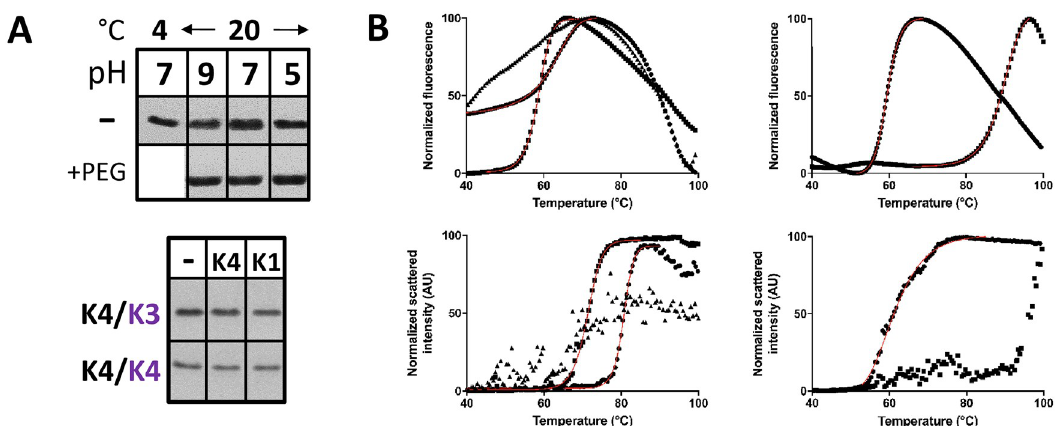
Fig 6. Stability of Syn6803 CcmK hetero-hexamers. A , Subunit exchange investigated by western blots. Top , FLAG signals recovered bound to TALON beads after reacting with purified His 4 -K4/K3-FLAG (7 μ M monomer concentration) that had been pre-incubated overnight, at pH ranging between 5 and 9, in the absence (top lane) or presence of 14% PEG 3350 (bottom). The first lane corresponds to a sample at pH 7 that was maintained at 4˚C throughout the overnight incubation. The bottom panel presents FLAG signals detected for indicated homo- and hetero-hexamers combining His 4 - and FLAG-tagged subunits (2 μ M final monomer concentration, indicated by black or violet letters, respectively) that were incubated overnight at room temperature and pH 8 in the absence or in the presence of untagged K4 or K1 homo-hexamers (6 μ M monomer). B , Thermal denaturation monitored by DSF ( top ) and DLS ( bottom ). Left panels present data collected for CcmK1 (triangles) and CcmK2 (circles) homo-hexamers, as well as for CcmK1/K2 hetero-hexamers (squares). Right panels show data for CcmK4 (squares) and CcmK3/K4 (circles). In DSF experiments, the proteins were incubated with the Sypro dye and the fluorescence of the probe was monitored as temperature was increased. For DLS assays, changes of the intensity of scattered light of hexamer solutions with temperature were recorded. DSF and DLS data were normalized before analysis. The mean of multiple measurement (see S4 Table) is shown with black symbols as well as the adjusted sigmoids (red lines). For each trace, only one every two recorded data points are displayed to facilitate figure interpretation.